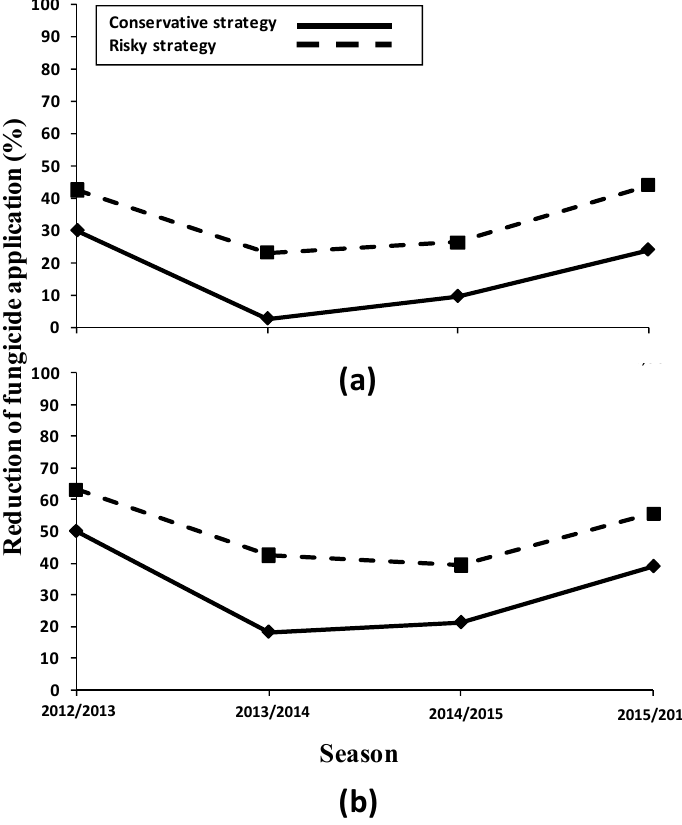
Figure 5. Four-season reduction in the total number of fungicide applications ( a ) and fungicide applications with copper as the active ingredient ( b ) in the conservative and risky strategies in comparison to the fungicide applications in the traditional strategy used as the control. There was a reduction in applications in terms of both the total and copper-based fungicides between the designed-by-authors strategies and the traditional strategy ( P = 0.001).